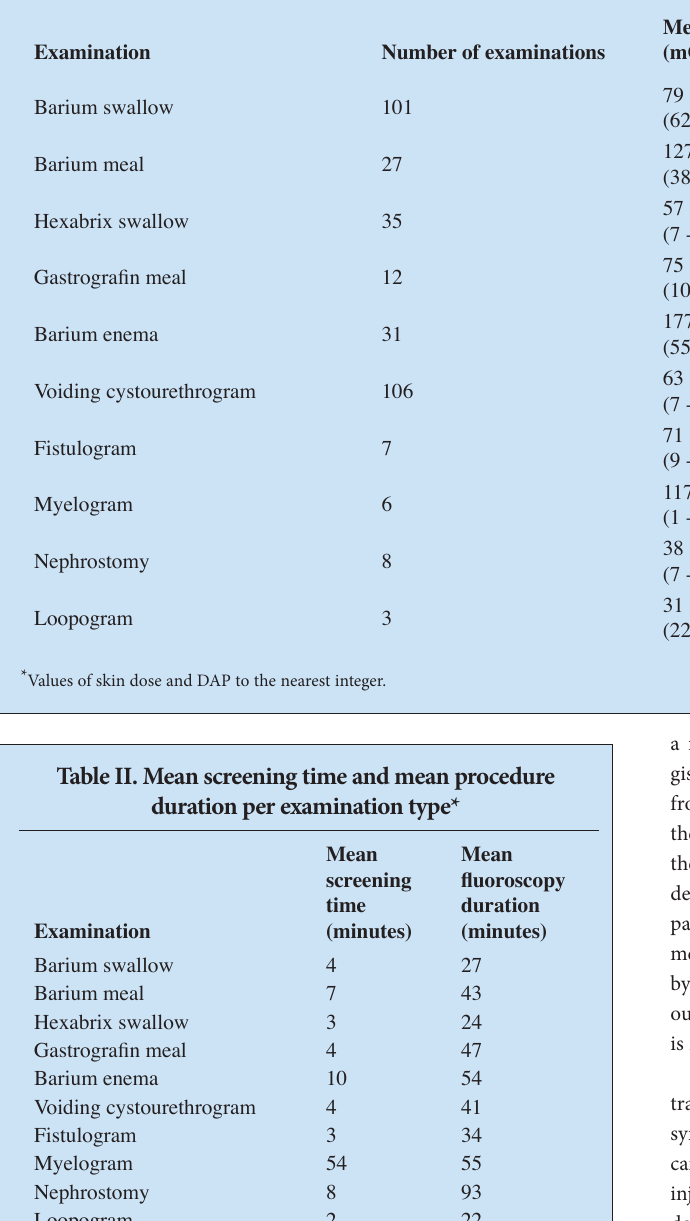
Table I. Mean skin dose and DAP for various examinations (range of measured skin dose and DAP readings in parentheses) Examination